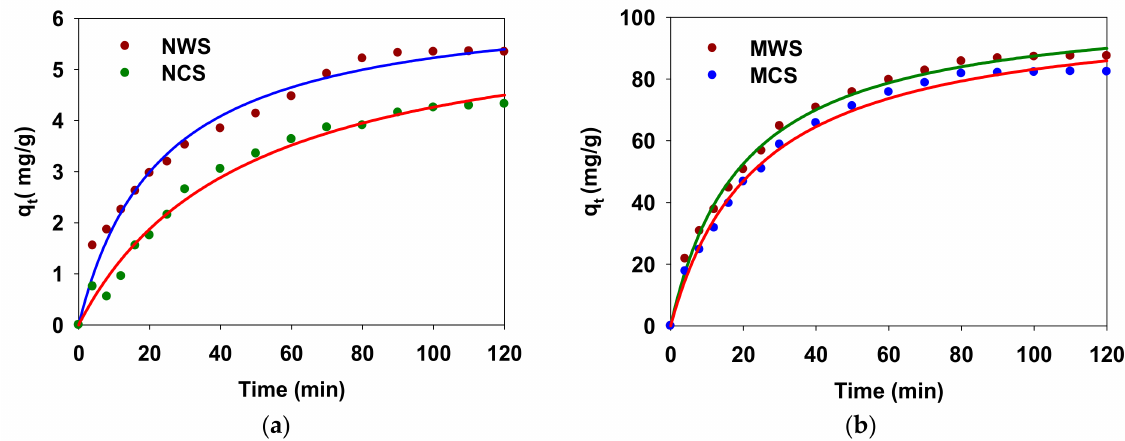
Figure 5. Effect of contact time on Pb(II) adsorption efficiency on to ( a ) native (NWS and NCS) and ( b ) modified (MWS and MCS) starch samples (Initial Pb(II) concentration 100 mg/L, speed 150 rpm, temp 22 ◦ C, pH 4.4, adsorbent dose 1